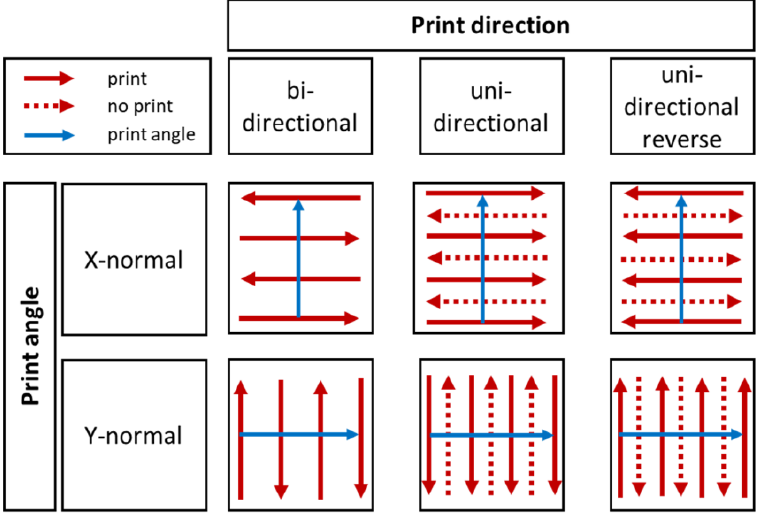
Figure 1. Illustration of used combinations of print direction ( red ) and angle ( blue ), modified according to the PixDro LP50 manual.